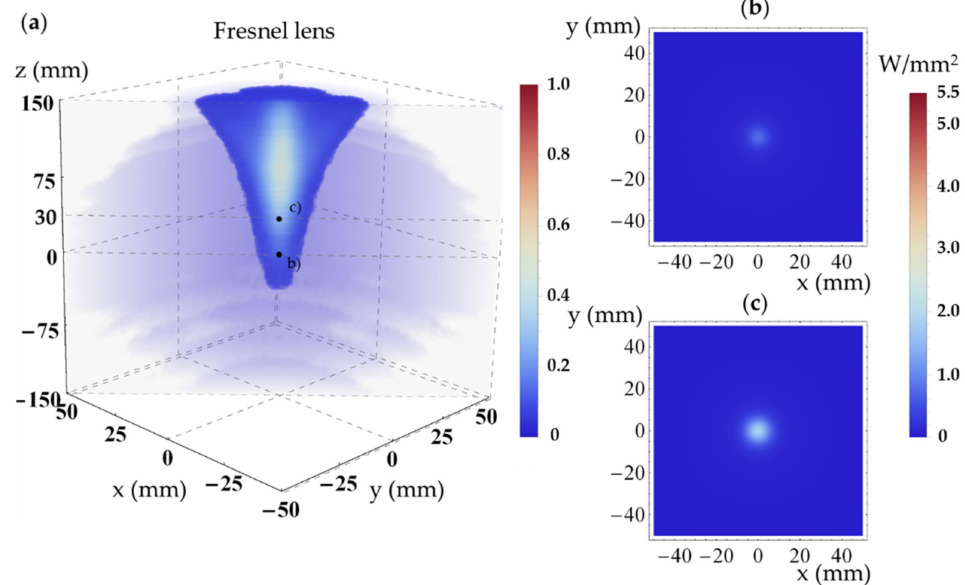
Figure 18. ( a ) Three-dimensional focal distribution of the flat Fresnel lens. ( b ) Top view of the light distribution at the focal point (Z = 0 mm). ( c ) Top view of the light distribution with the highest concentrated solar flux (Z = 30